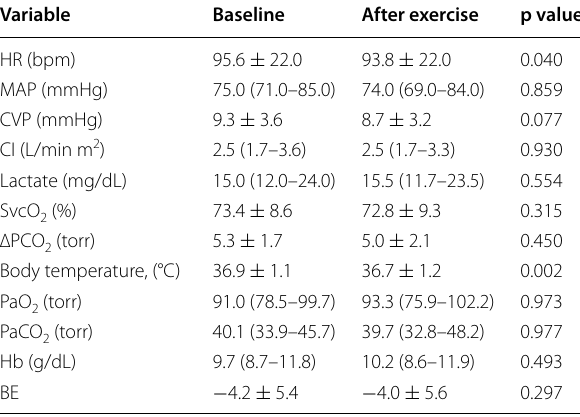
Table 2 Systemic hemodynamic and ventilation